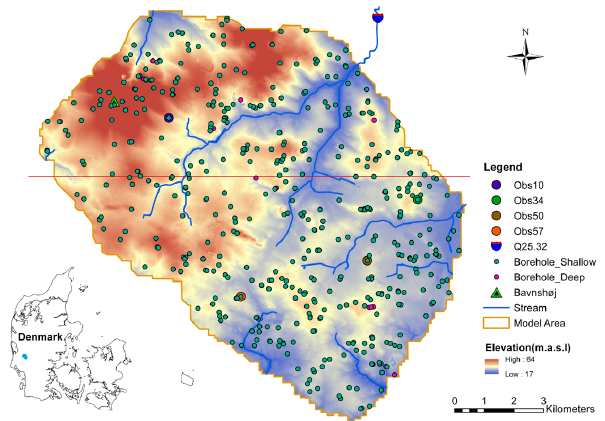
Fig. 1. Topography, stream network and observation stations around Ølgod. “Borehole Shallow” are boreholes with bottom elevation higher than − 70ma.s.l., while “Borehole Deep” are boreholes with bottom elevation lower than − 70ma.s.l. The red line indicates the location of the cross section in Fig. 2.